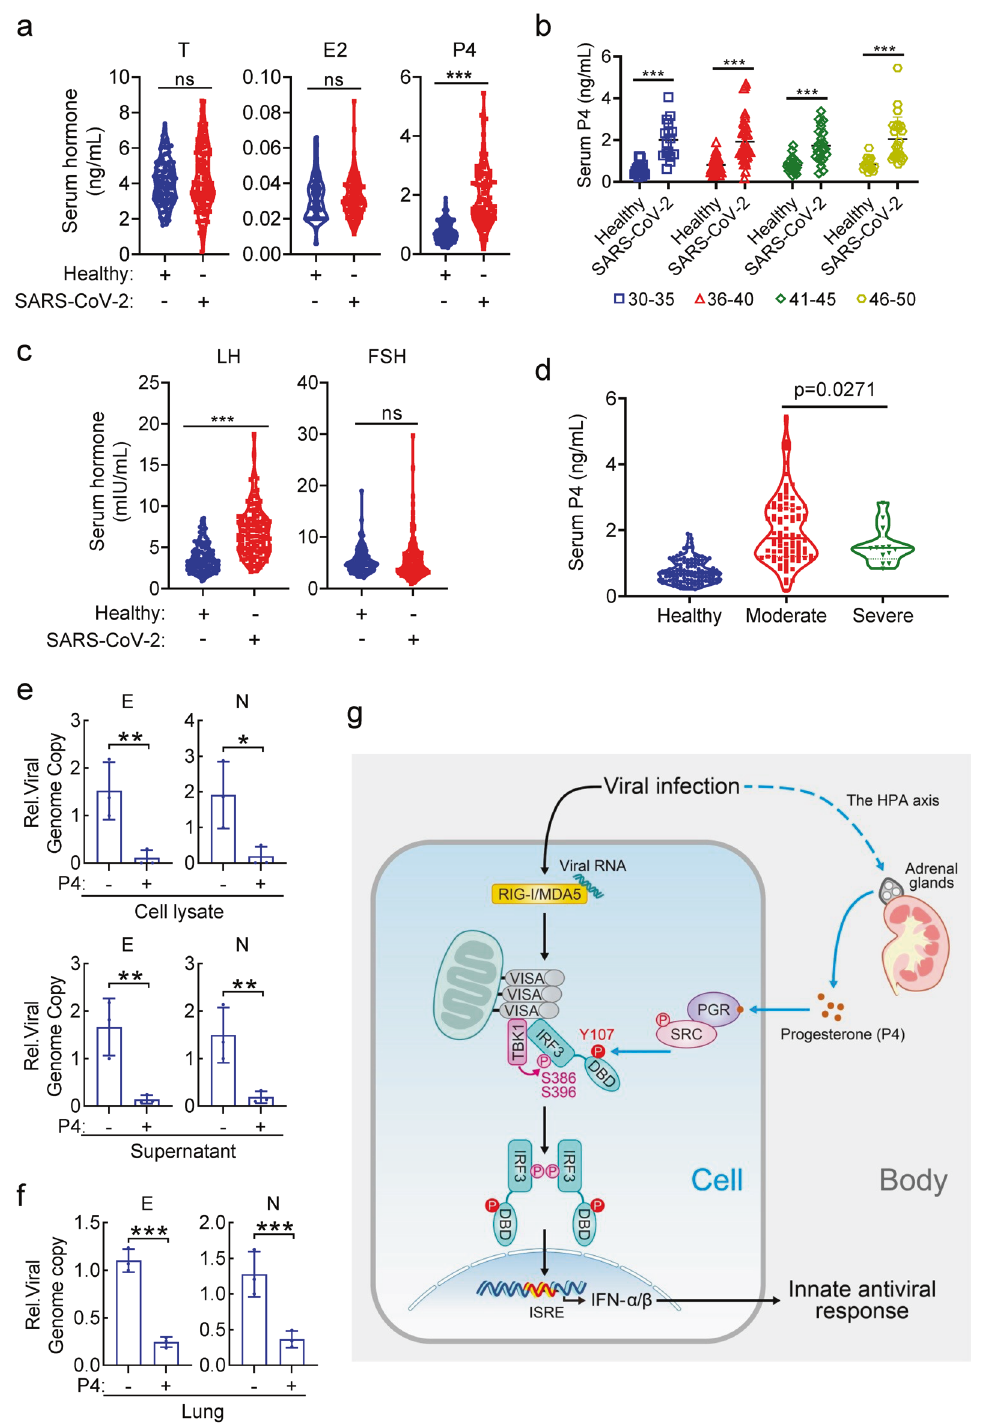
Fig. 6 SARS-CoV-2 infection increases serum progesterone levels in COVID-19 patients. a – c Analysis of sex-related hormones in healthy individuals and SARS-CoV-2-infected patients. The measurements of testosterone (T), estradiol (E2) and progesterone (P4) are shown in ( a ). The age-classi fi ed data of P4 are shown in ( b ). The measurements of LH and FSH levels are shown in ( c ). * P < 0.05; ** P < 0.01; *** P < 0.001; ns, not signi fi cant. d Correlation analysis between progesterone levels and severity of symptoms of COVID-19. e Effects of progesterone on replication of SARS-CoV-2 in Calu-3 cells. Calu-3 cells were treated with P4 (1 μ M) for 1 h and then infected with SARS-CoV-2 (MOI = 0.01) for 48 h. Total RNAs in both cell lysate and the supernatant was collected to detect the envelope ( e ) and nucleocapsid (N) RNA of SARS-CoV-2 via TaqMan-qRT-PCR. f Effects of progesterone on replication of SARS-CoV-2 in mice. The K18-hACE2 transgenic mice ( n = 3 in each group, 8- week-old male) were injected intraperitoneally (i.p.) with DMSO or P4 (30 μ g/kg) for half an hour, and then intranasally infected with 250 PFU of SARS-CoV-2 in a total volume of 50 μ l DMEM. Mice were then continued to be administered with DMSO or P4 daily until fi ve days post- challenge. Viral genomic copy numbers in the lungs of infected mice were quanti fi ed by qPCR. g A work model for modulation of innate antiviral response by humoral progesterone